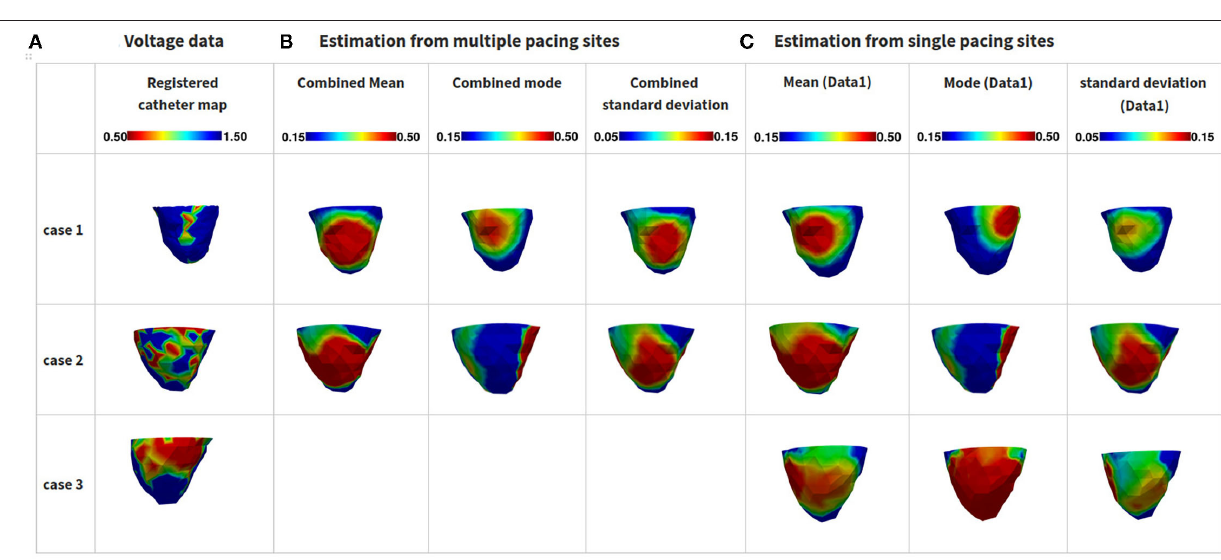
FIGURE 7 | Results of estimated tissue excitability from the presented method in 3D infarcts delineated from in vivo MRI images. Regions with low excitability (high θθθ values) correspond to infarct regions (0.5 infarct core, 0.3–0.5 gray zone). The red circles highlight non-transmural scars or gray zone. = =